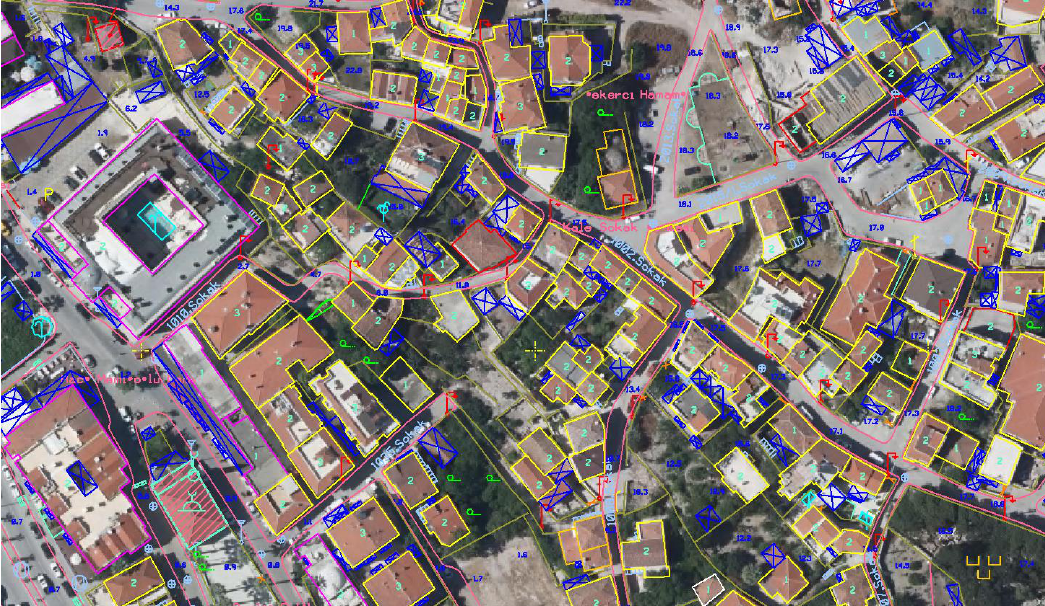
Figure 6. Manual feature extraction from stereo aerial images.